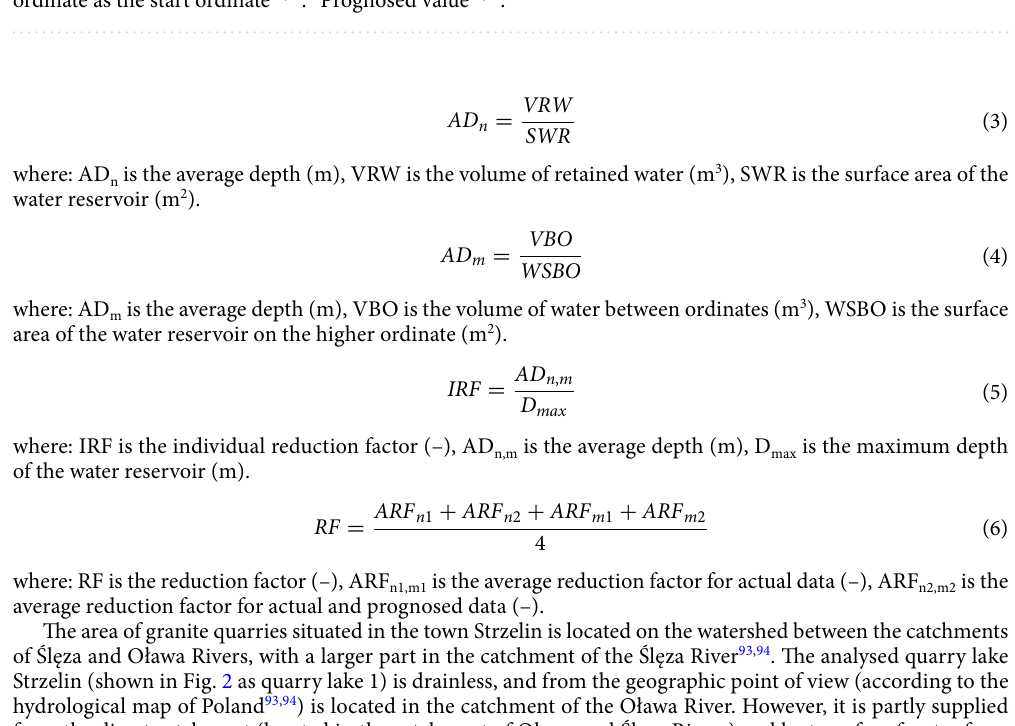
Table 1. Determination of the RF reduction coefficient. a Water volume calculated from the 66.6 m a.s.l. ordinate as the start ordinate 14,32 . b Prognosed value 14,32